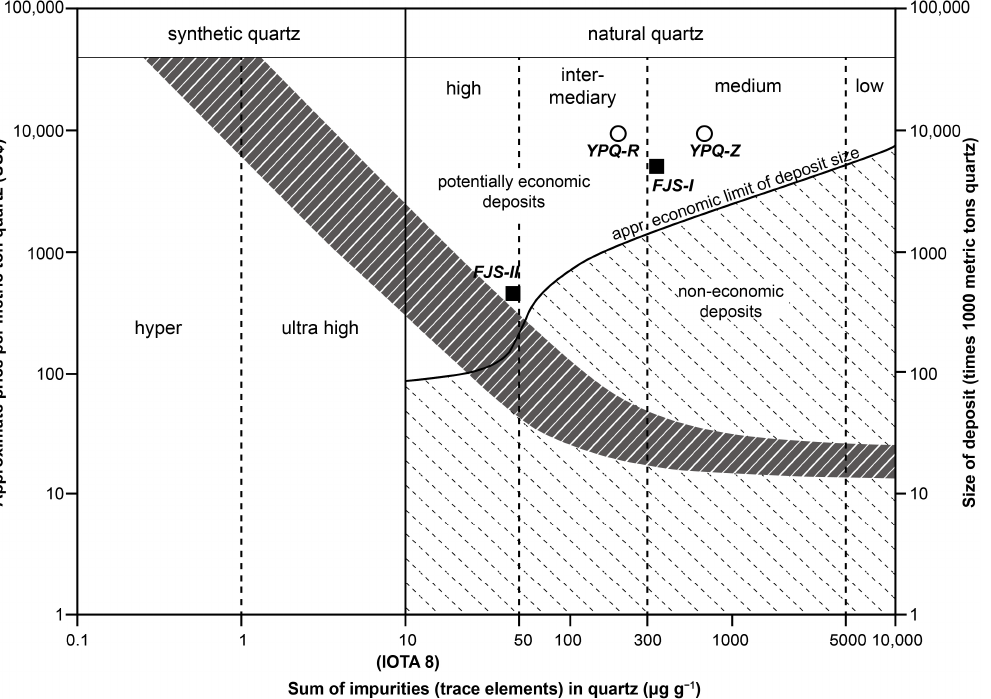
Figure 7. Graph of quartz size, total trace element content, and price estimation range according to Harben [15] and Müller et al. [6] illustrating economic potential of the Fujiashan and Yipanqiu quartz deposits. The projection indicates the Fujiashan-II vein falls into the high-purity quartz field and be of economic interest. FJS-I = Fujiashan I vein, FJS-II = Fujiashan II vein, YPQ-R = Yipanqiu vein quartz at Renyou locality, YPQ-Z = Yipanqiu quartz vein at Zimudong locality.